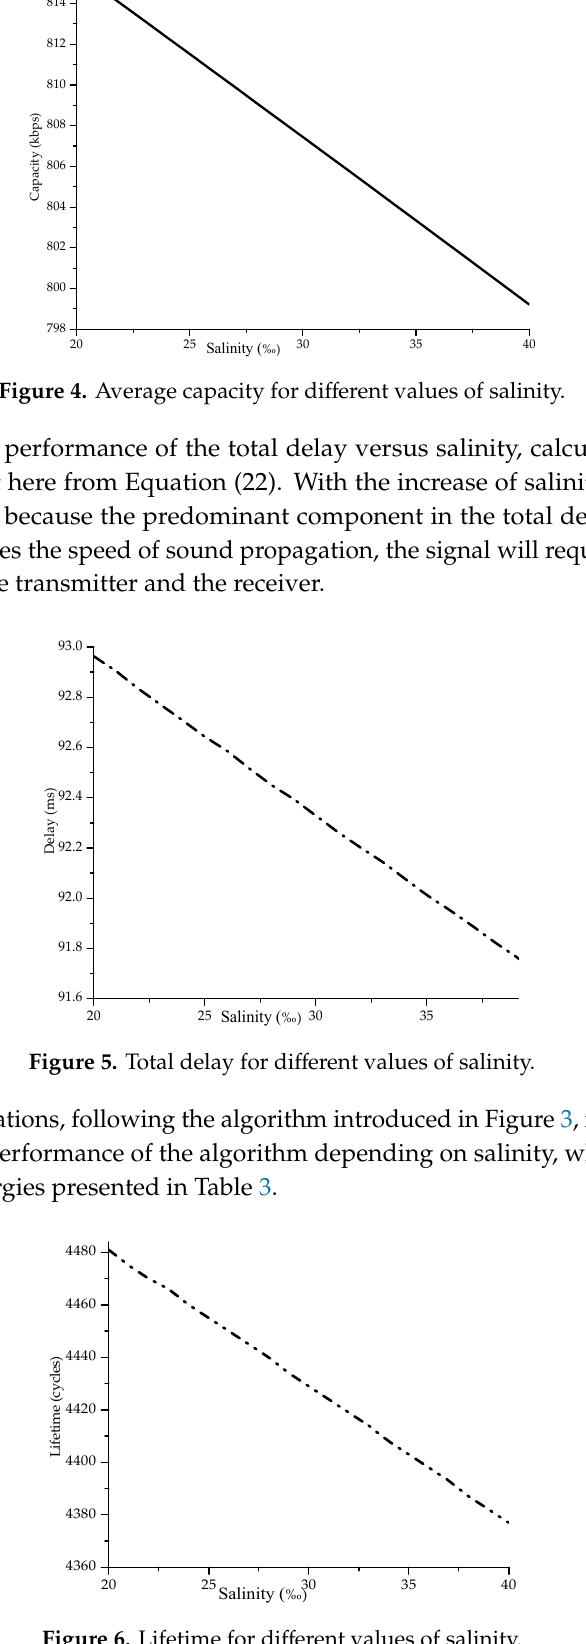
Figure 6. Lifetime for different values of salinity .